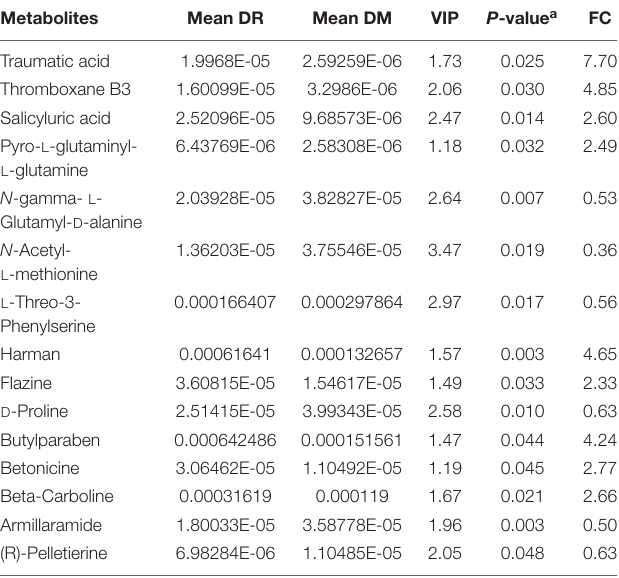
TABLE 2 | Identified differential Fecal metabolites between DR patients and DM patients.